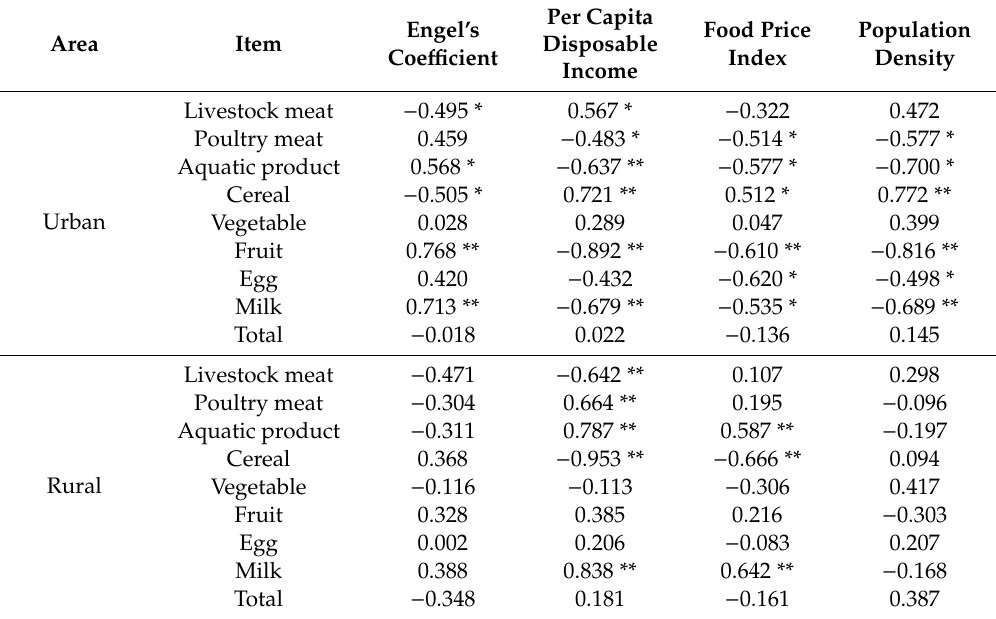
Table 3. Correlation coe ffi cients between food N footprints per capita and various economic factors in Shanghai from 2000 to 2017.